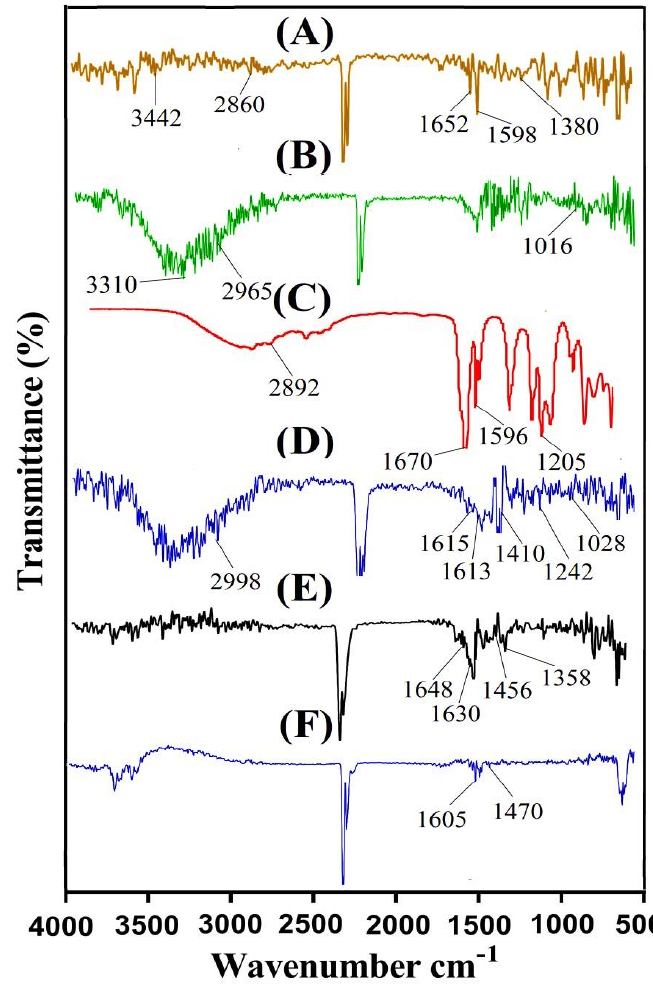
Figure 2. FTIR spectra of ( A ) CS, ( B ) β -CD, ( C ) Aa, ( D ) unloaded CS/ β -CDcPAa hydrogel, ( E ) 5-ASA, and ( F ) loaded CS/ β -CDcPAa hydrogel.